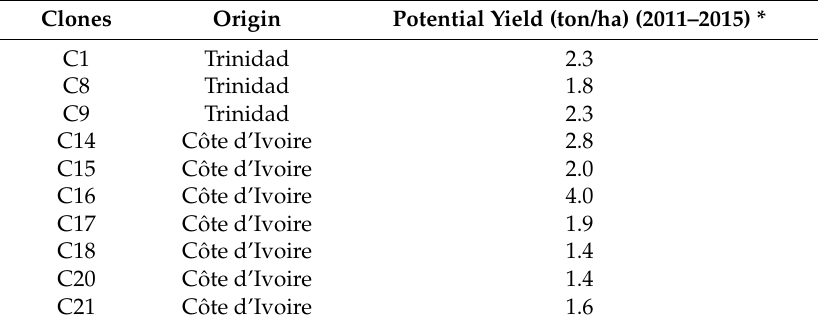
Table 1. Origin and potential yield of the ten cocoa clones used in this study.